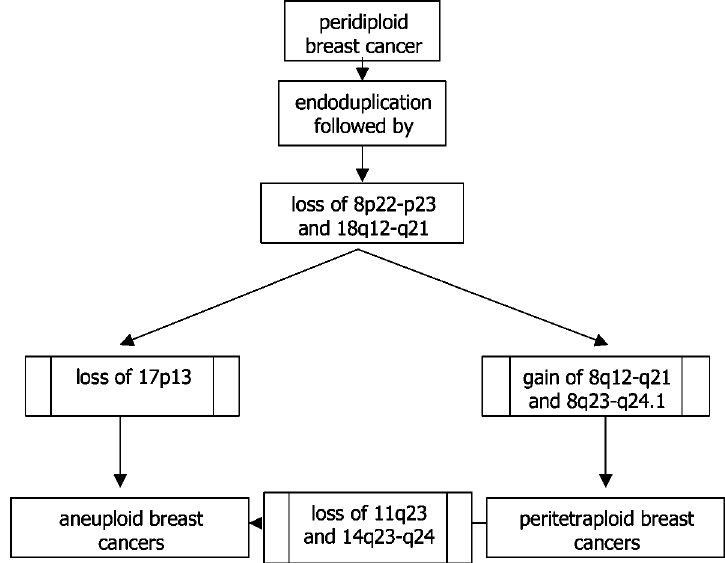
Fig. 10. A possible model of progression from peridiploid to peritetraploid and aneuploid breast